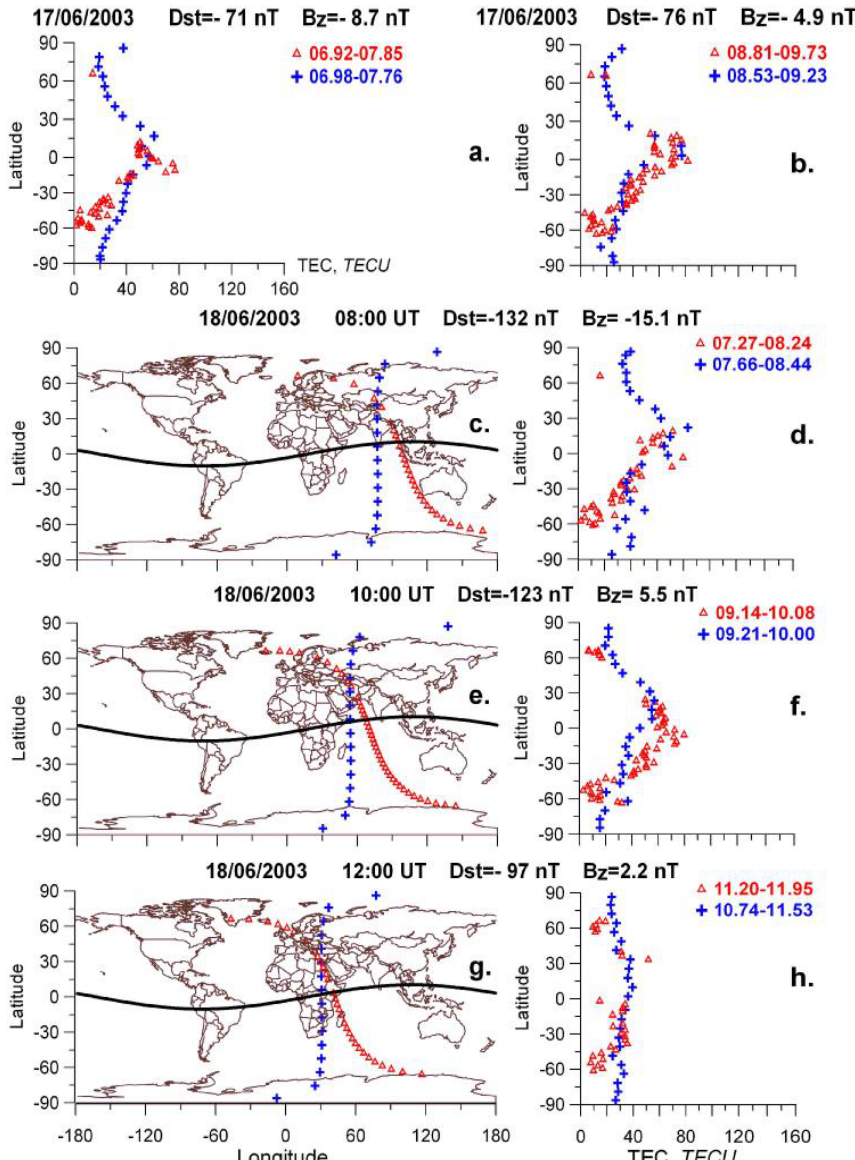
Fig. 6. The same as in Fig. 3 but for 17 June 2003 (a) , (b) and the geomagnetic storm on 18 June 2003 (c–h) . The satellites pass near the following sectors: Jason-1 ∼ 14:20LT, CHAMP ∼ 13:00LT. No data of the SAC-C satellite were